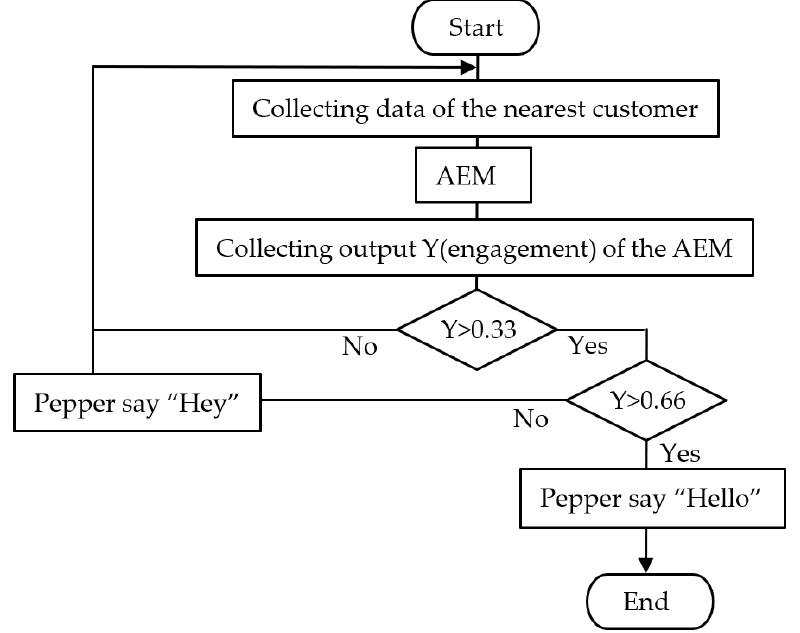
Figure 4. Automatic greeting mode in the robot